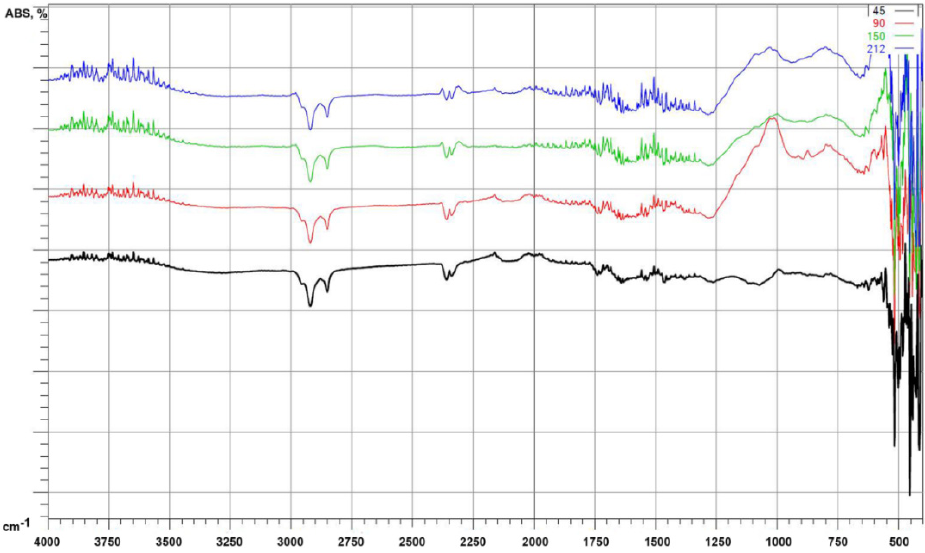
Figure 11. FTIR spectra for raw CSs: 45-F_45, 90-F_90, 150-F_150, and 212-F_212.